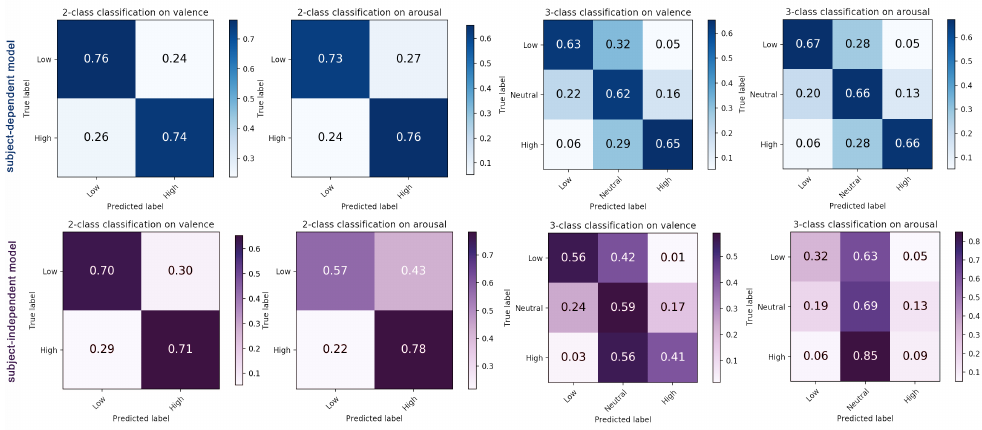
Figure 9. The result of 10-fold cross validation (subject-dependent model, up ) and leave-one-subject- out cross validation (subject-independent model, down ) on MERCA.